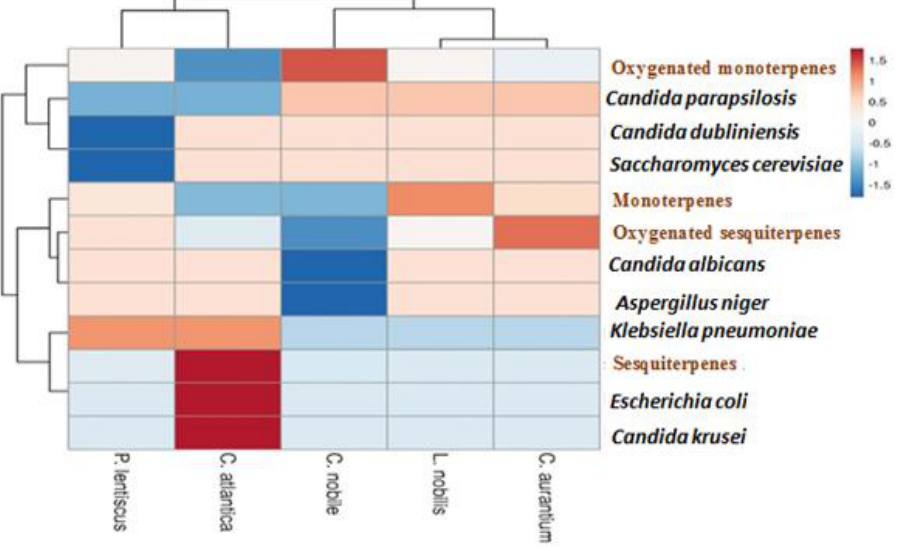
Figure 6. Correlation between the chemical composition of essential oils and their antimicrobial ac- tivities.